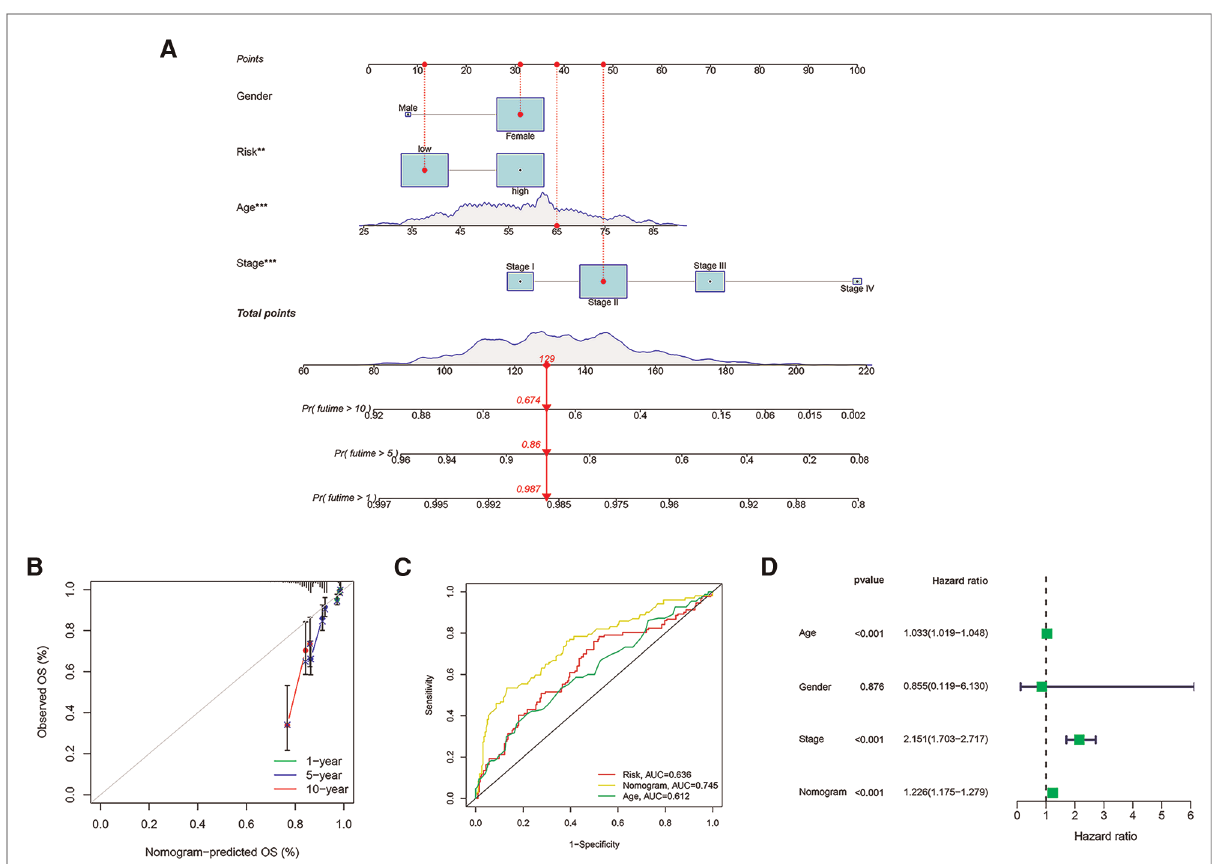
FIGURE 9 Establishment of a nomogram based on GRG signature. ( A ) The nomogram integrating GRG risk score, gender, age and stage. ( B ) The calibration curves for the probability of 1-, 5- and 10- years OS. ( C ) The ROC curves of nomogram, risk score and other clinicopathological characteristics. ( D ) Cox regression analysis of